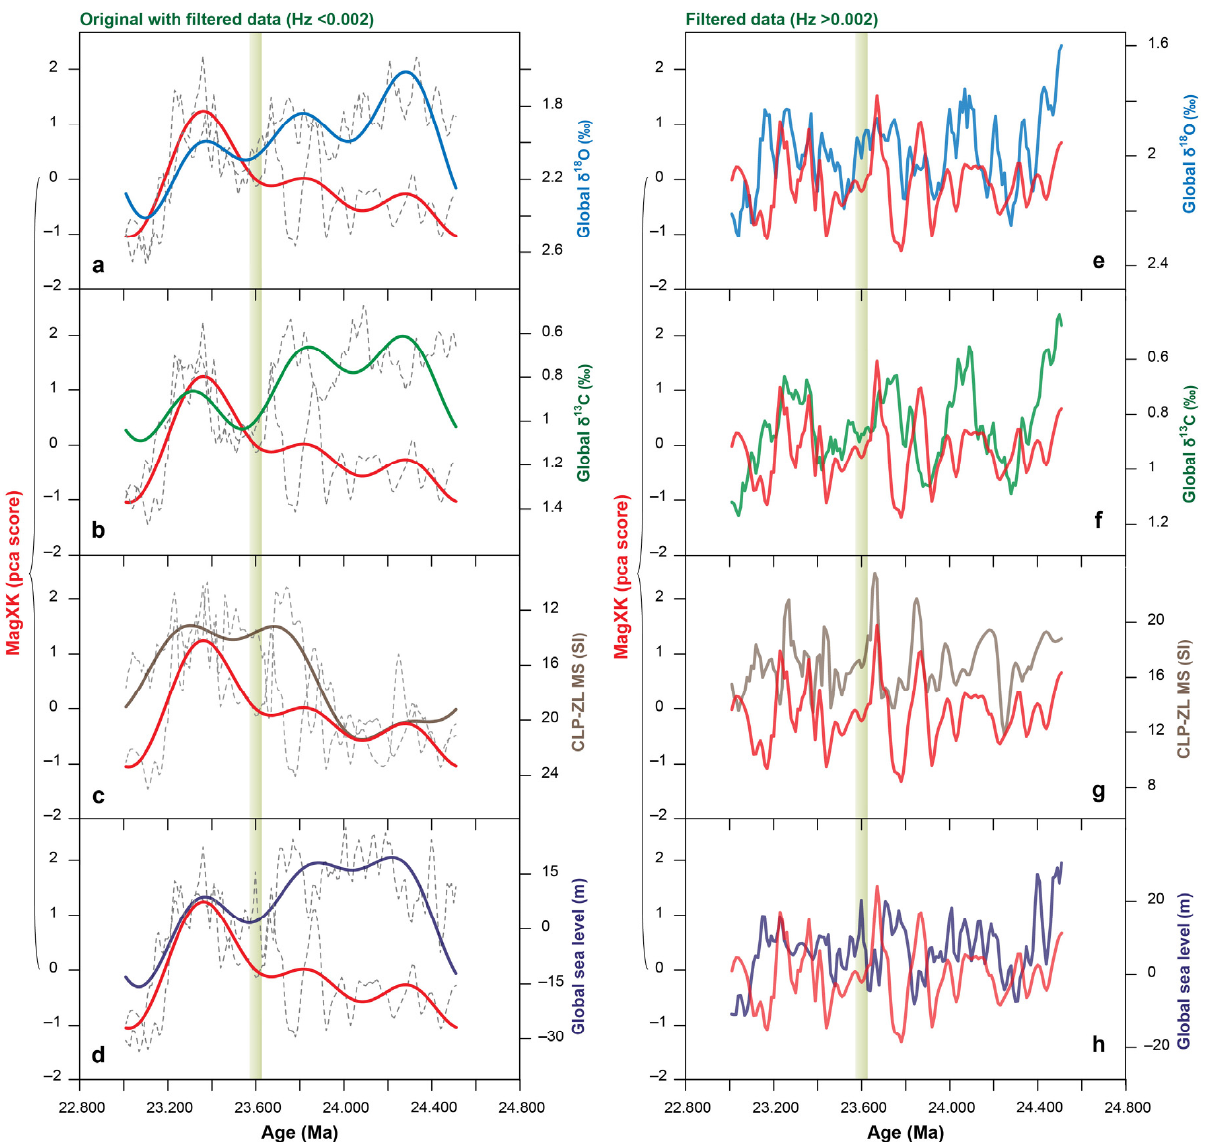
Figure 7. Comparison between the MagXK of core XK-1 and various paleoenvironmental proxies. ( a – f ) The MagXK of core XK-1 versus global δ 18 O and δ 13 C records [16]. ( c , g ) The MagXK versus the CLP-ZL MS, the loess magnetic susceptibility of Zhuanglang Profile in the Chinese Loess Plateau [61]. ( d , h ) The MagXK versus global sea level [62]. Dashed lines, original data; bold lines on the left panel, low-passed-filtered component (FFT filter, >0.5 Myr); lines on the right panel, high-passed-filtered component (FFT filter, <0.5 Myr).